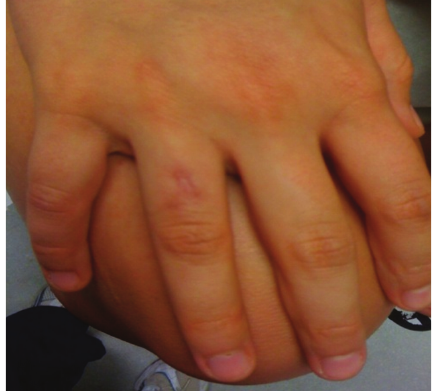
Figure 2: M. fortuitum . Clinical picture of dermal piercing site after full treatment; scar formation present from biopsy